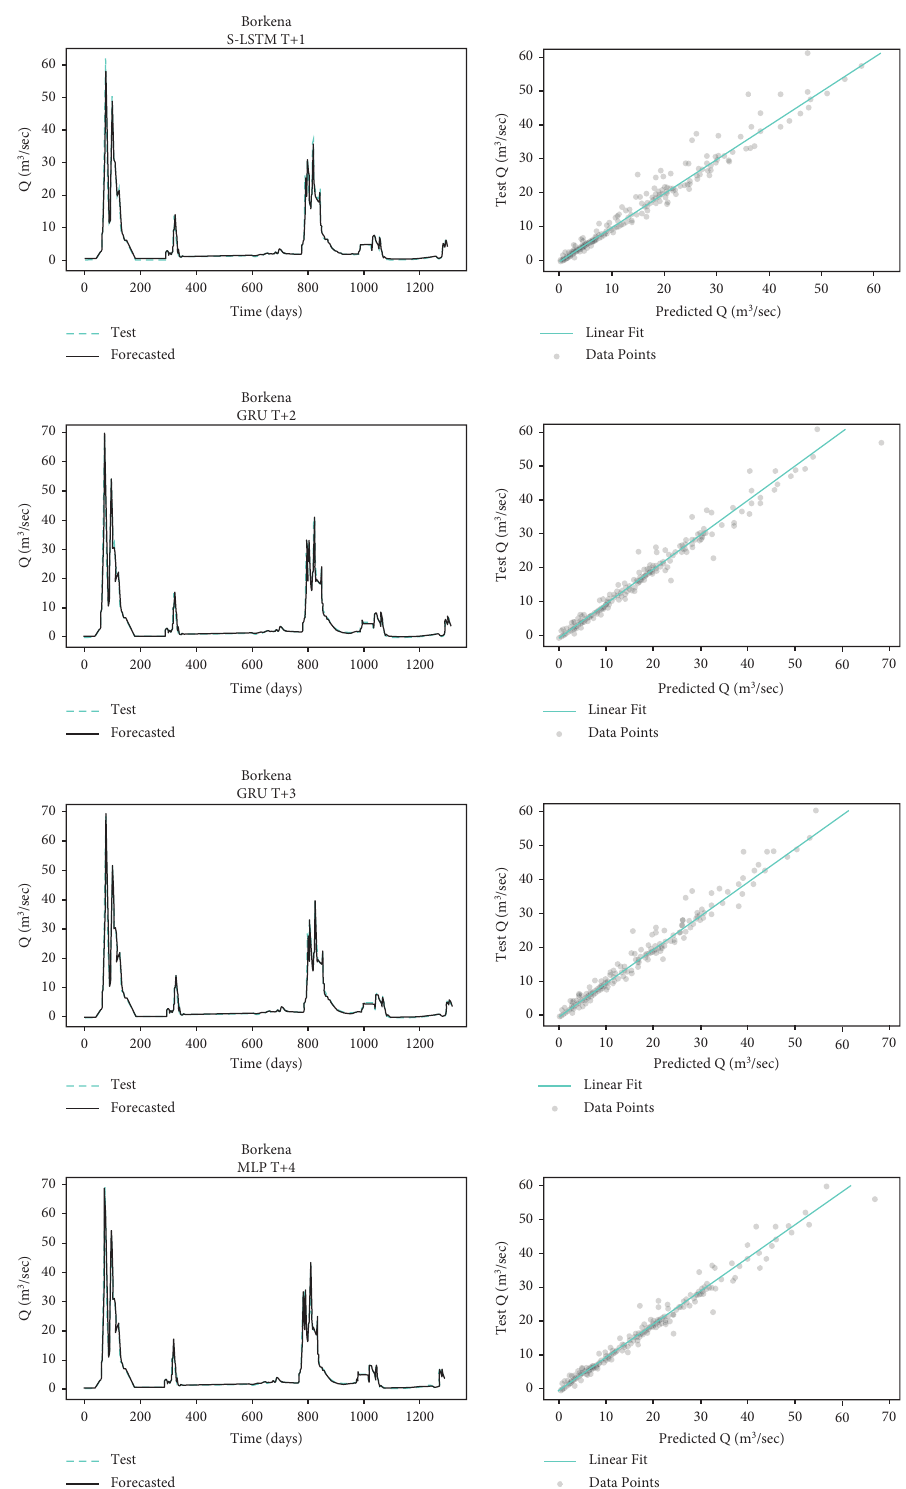
Figure 13: Comparison of true values and predicted values of the optimized high score deep learning model for each time lag (Borkena